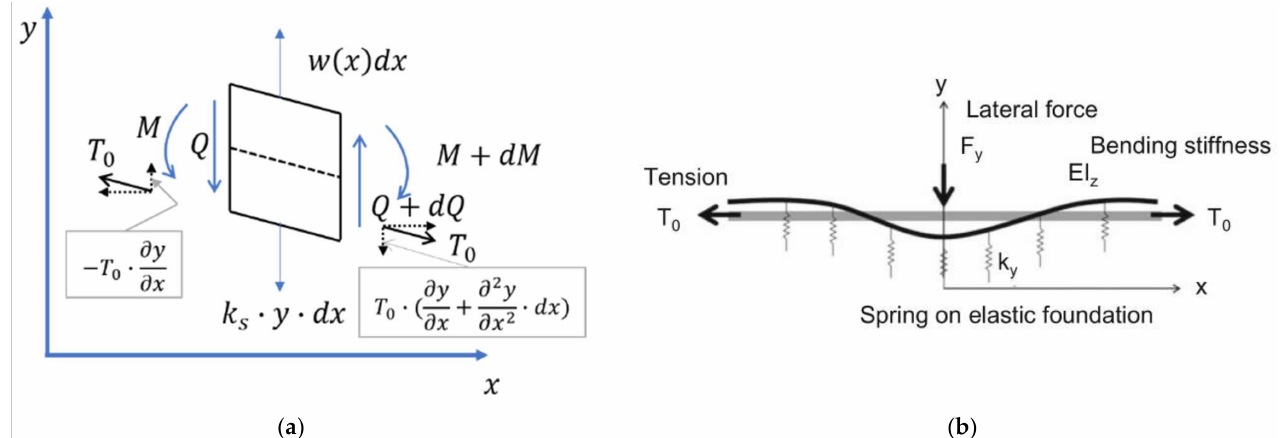
Figure 2. Model of the beam on the elastic foundation. ( a ) The equilibrium of forces for the beam section; ( b ) Belt/carcass deformation applied F y